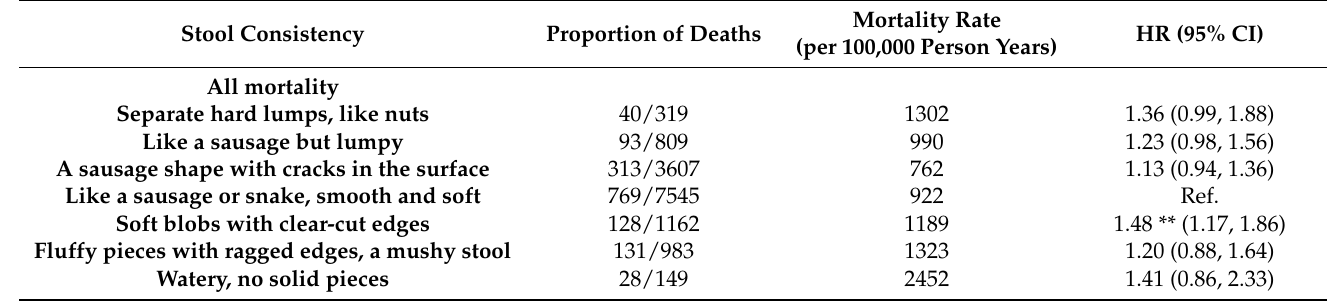
Table 3. Associations between the stool consistency and all-cause, cancer-, and CVD-specific